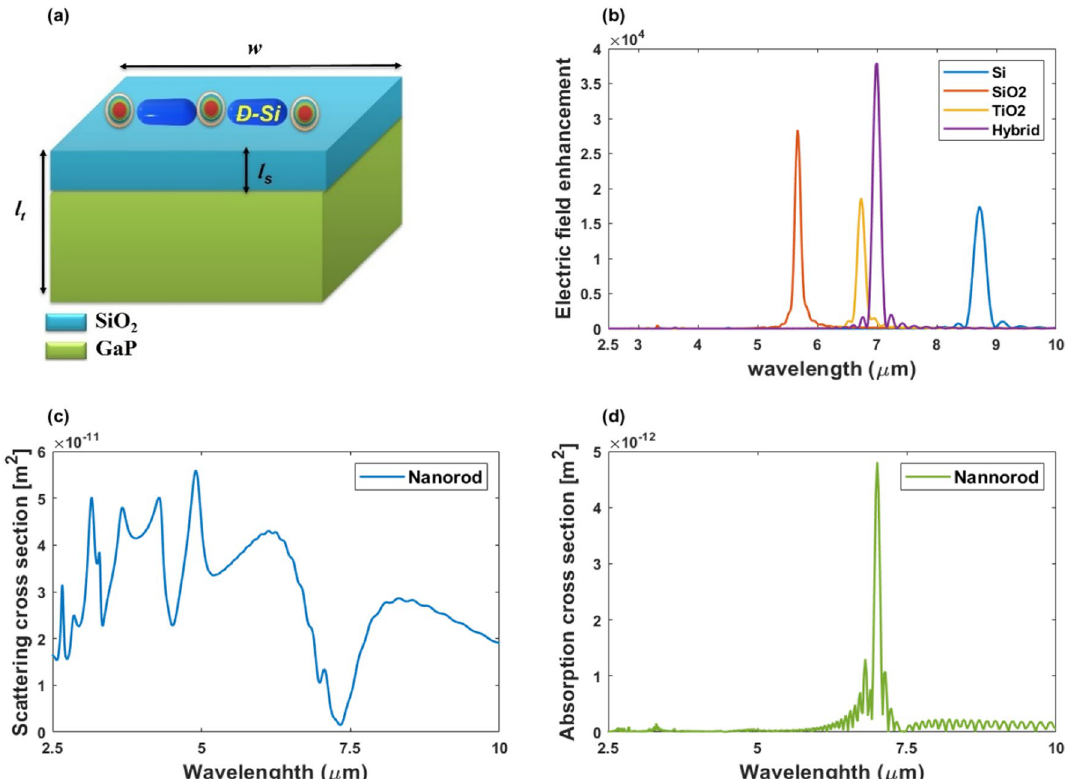
Figure 7. ( a ) Schematic of the nanorod antenna on the top of the hybrid substrate, ( b ) variation of the wavelength-dependent intensity enhancement with different substrate materials. ( c ) The scattering cross-section of the nanorod on the hybrid substrate as a function of the wavelength. ( d ) The absorption cross-section of the nanorod on the hybrid substrate as a function of the wavelength.